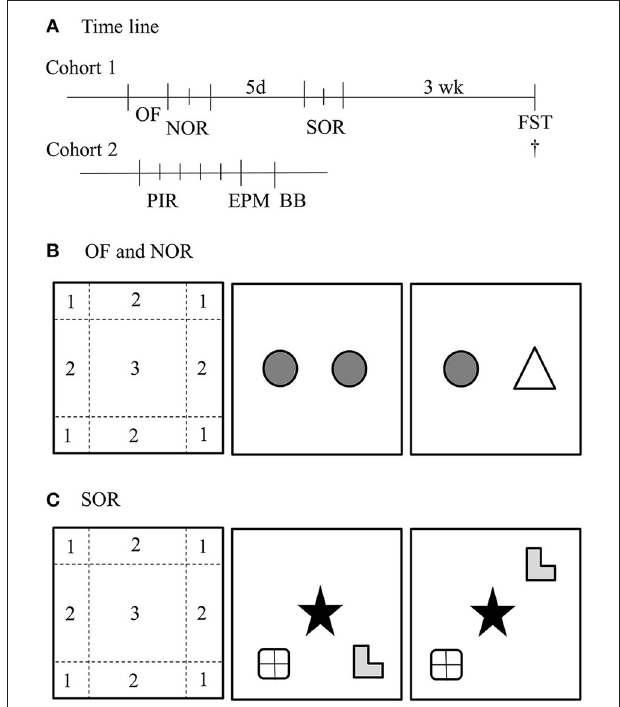
FIGURE 1 | Overview of behavioral paradigms. (A) Time line of the study. The first cohort started with an open field (OF) and novel object recognition test (NOR), 5 days later followed by a spatial object recognition test (SOR) and 3 weeks later a Forced swim test (FST). After the FST, the mice were sacrificed. The second cohort was monitored for 5 days with passive infrared sensors (PIR), subsequently 24h later tested in the elevated plus maze (EPM) and 24h later on the balance beam (BB). (B) OF and NOR setup. The habituation phase of the NOR was used as OF. For the analysis with ethovision, the arena was divided in three regions; (1) corner, (2) border, and (3) center. The NOR was started 24h after the habituation phase, in which the animals could freely explore two identical objects. Again 24h later, one object was replaced for a new object. (C) The SOR was performed in 2 days. The first day the mice were exposed to four trials of 6min with a 6min break in between. The first trial was a habituation phase and the second to fourth trial the mice could explore three different objects in a specific configuration. 24h later, one object was moved to another position. † Depicts the time of